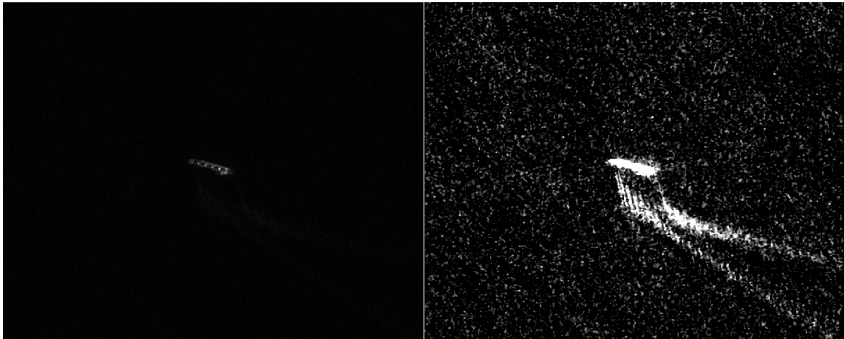
Figure 1. Example of the crop image of a navigating vessel ( left ), cut out from a larger SAR map. (COSMO-SkyMed Product— c (cid:13) ASI 2016 processed under license from ASI—Agenzia Spaziale Italiana,